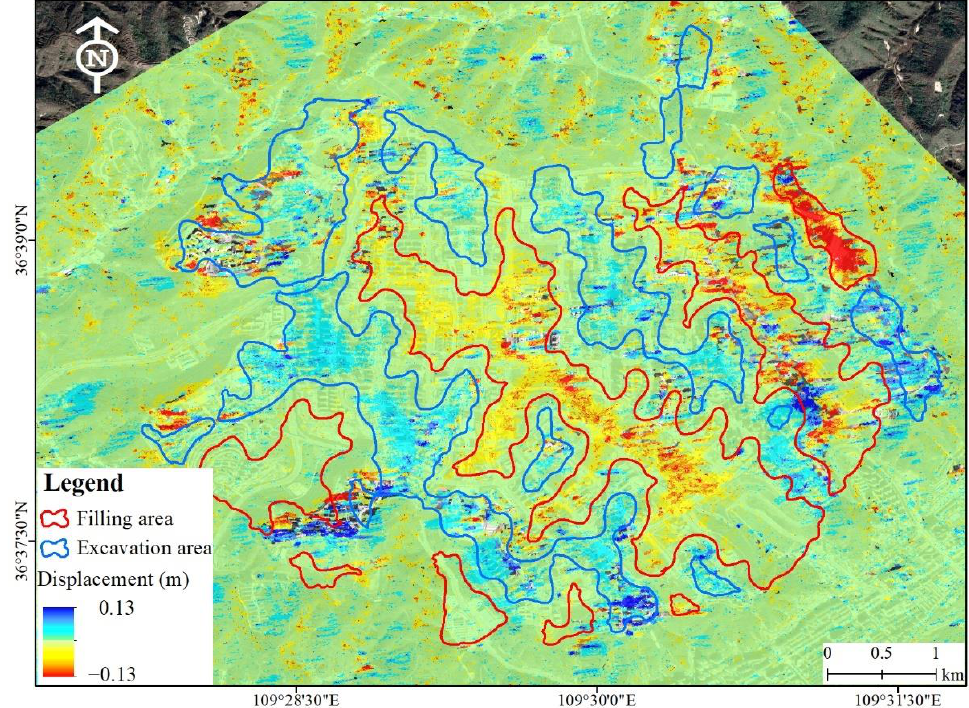
Figure 7. Surface deformation image of Yan'an New District from 2018 to 2019 calculated using DInSAR. Positive values indicate that the ground object deformation is close to the radar along the radar LOS, and negative values indicate that the ground object deformation is far away from the radar along the radar LOS.